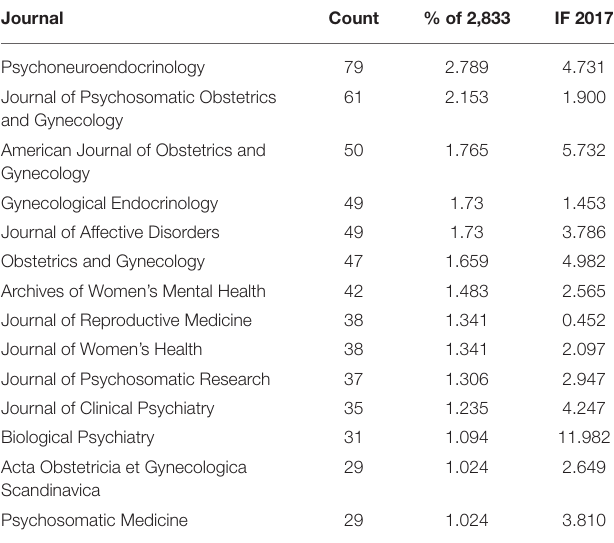
TABLE 2 | The top 15 journals with publications on PMS/PMDD research from 1945 to